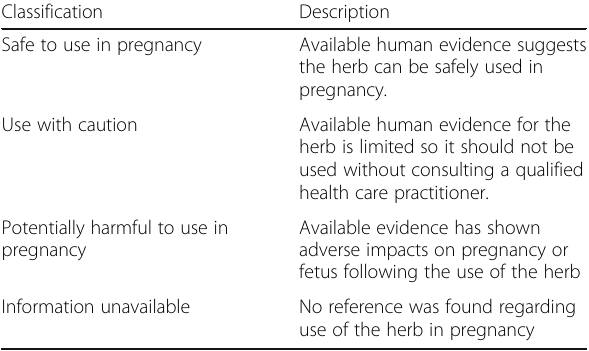
Table 1 Safety classification of identified herbal medicines